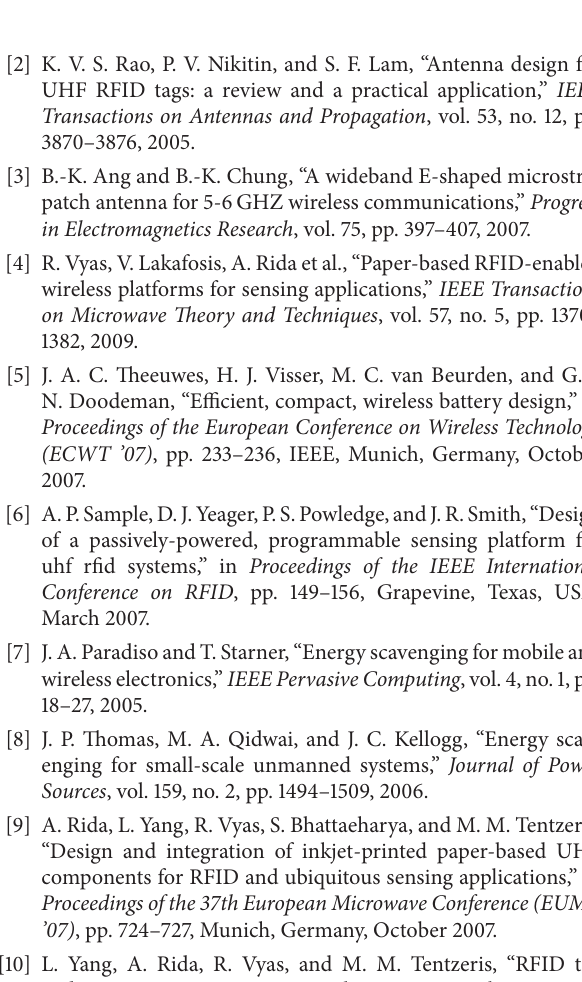
Figure 8: 2D model of the radiation pattern of the gain of theta and phi at phi = 0 “to the left” and 90 ∘ “to the